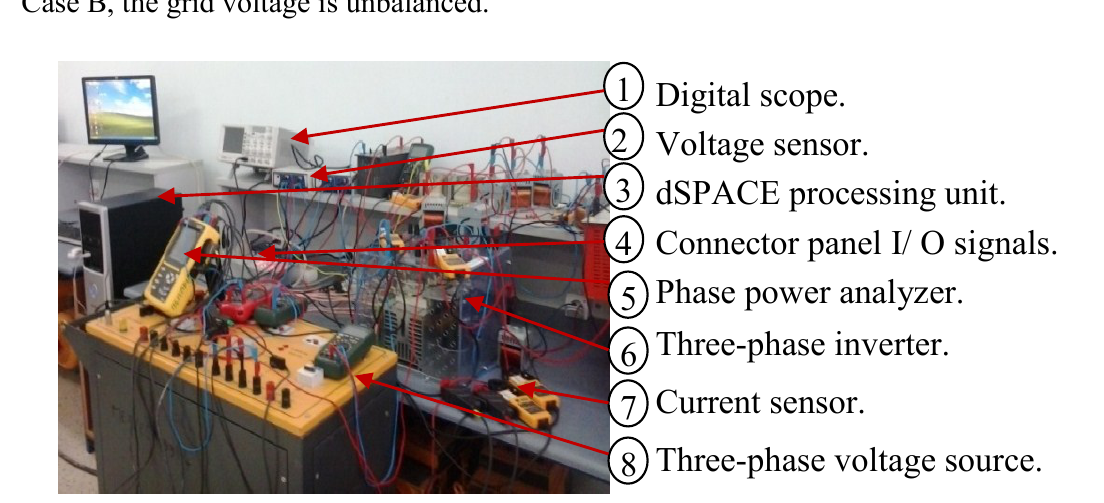
Figure 16. Experimental set